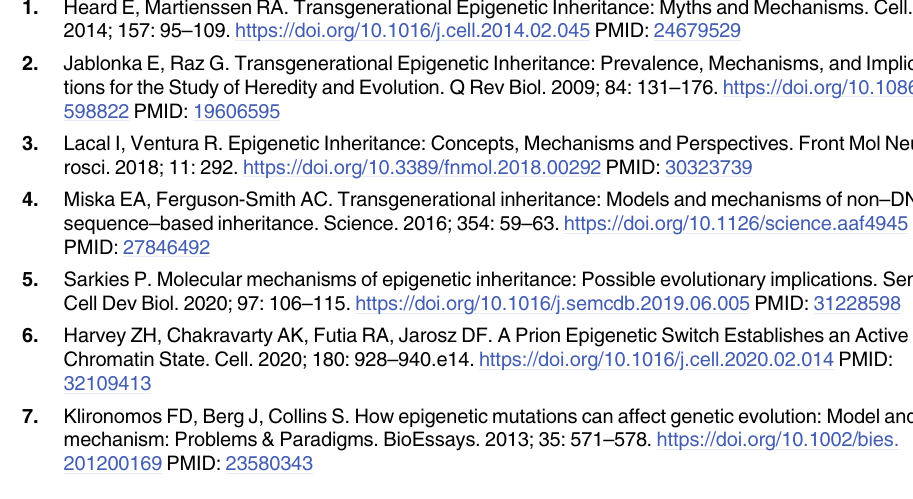
S55 Table. Table of values used in S9 Fig File name: S55_Table.csv. S56 Table. Table of values used in Table 1. File name: S56_Table.csv. S57 Table. Table of values used in Table 2. File name: